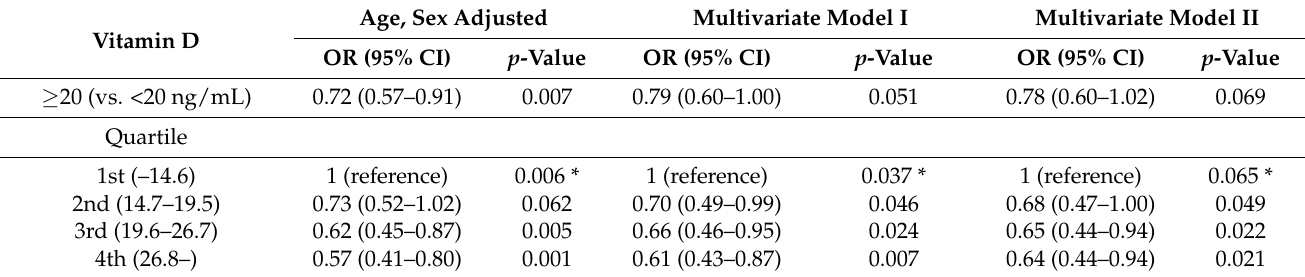
Table 3. Multivariate analysis for the association between vitamin D and hepatic steatosis.